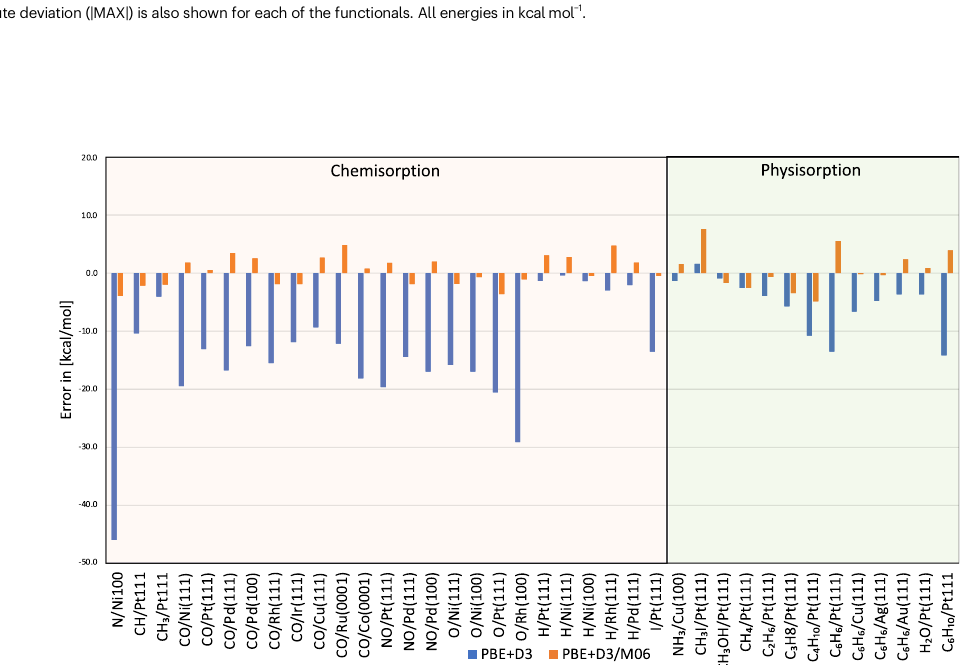
Table 1 | MAE and RMSE for chemisorption (Chem.), physisorption (Phys.) and combined (Tot.) using PW91, PBE, RPBE, GAM, MN15-L, BEEF-vdW, SCAN, PBE+D3 and PBE+D3/M06 PW91 a PBE b RPBE a GAM b MN15-L b BEEF-vdW a SCAN c PBE+D3 d PBE+D3/M06 d MAE-Chem. MAE-Phys. MAE-Tot. RMS-Chem. RMSE-Tot.